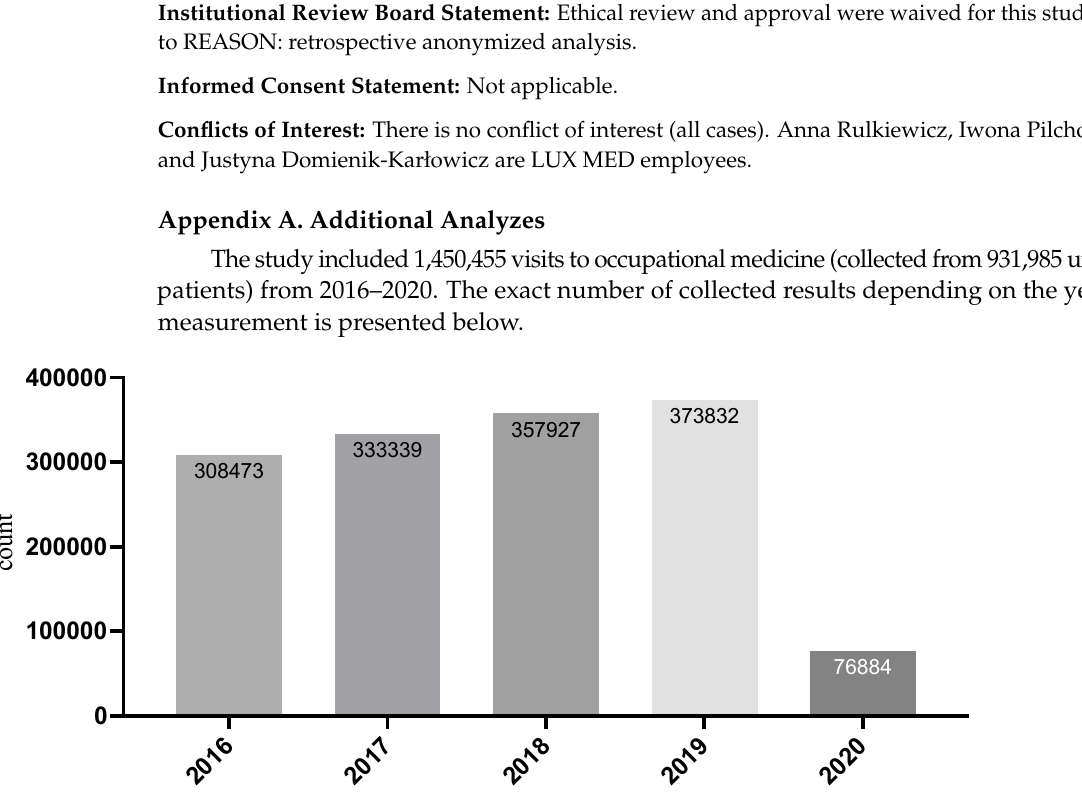
Figure A2. Sex distribution depending on the year of measurement. The age of the respondents ranged between 14 and 90 years (M = 36.59; SD = 11.56). A slight trend was observed indicating the mean age of the examined patients slightly increased with each year of measurement (see Figure A3). Clarification: patients can change age categories if their change in age necessitates this; this is not to be misinterpreted for a tautological restatement of the patients aging with time. Figure A3. Patient age distribution versus the year of measurement.